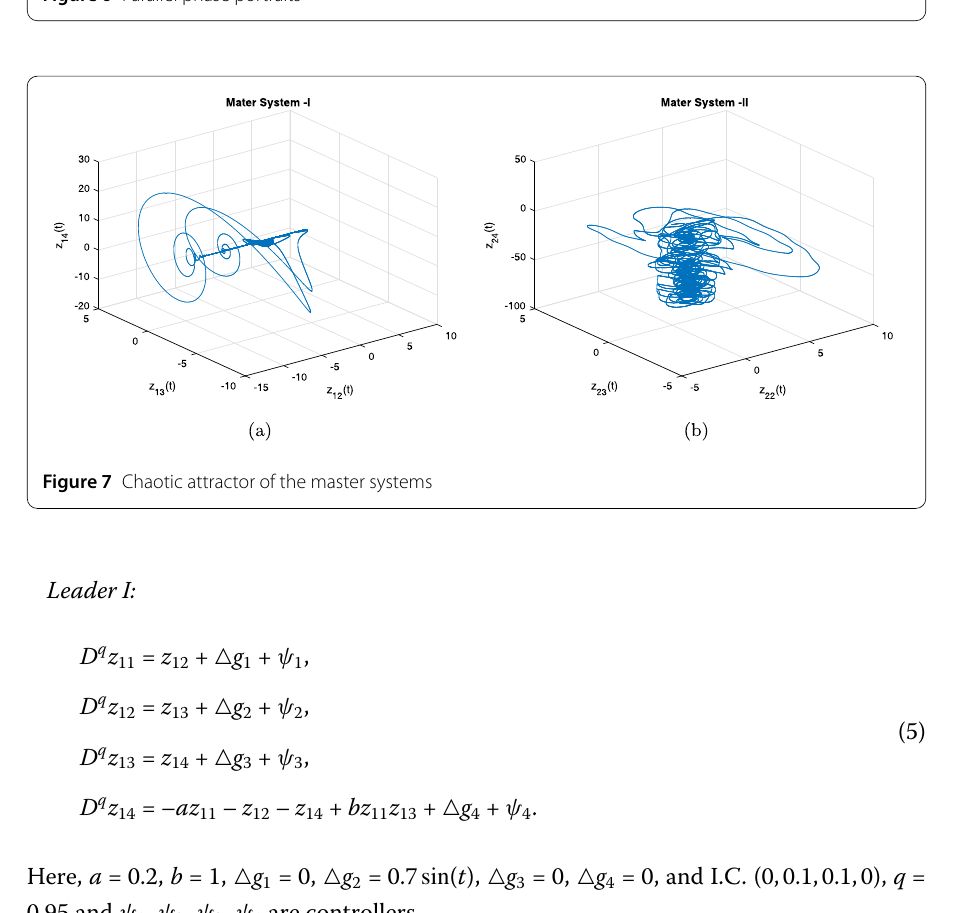
Here, a = 0.2, b = 1, (cid:9) g 1 = 0, (cid:9) g 2 = 0.7 sin ( t ), (cid:9) g 3 = 0, (cid:9) g 4 = 0, and I.C. (0,0.1,0.1,0), q = 0.95 and ψ 1 , ψ 2 , ψ 3 , ψ 4 are